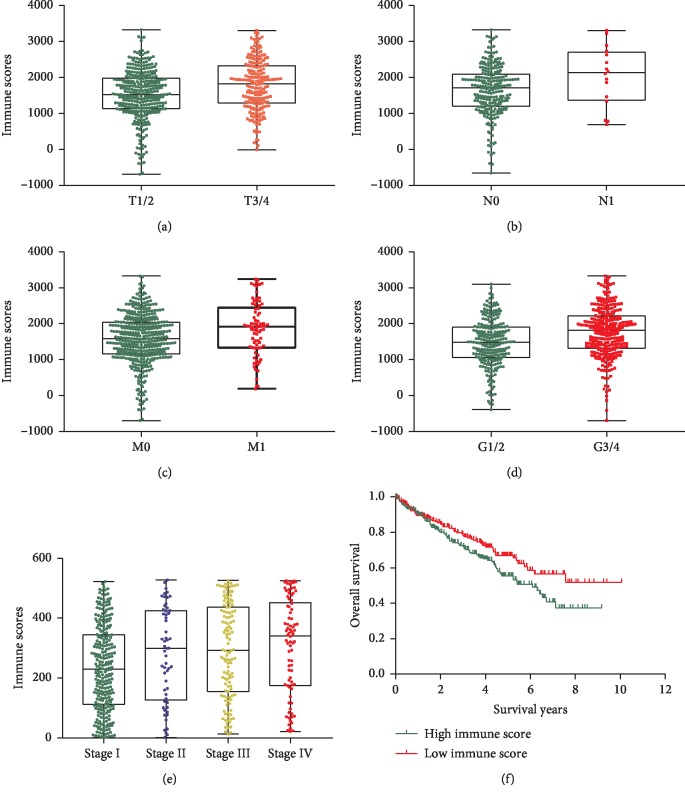
Immune scores were associated with clinical characteristics and overall survival. (a) Distribution of immune scores stratified by T status and box plot indicates a higher immune score was associated with T3/4 (vs. T1/2, P < 0.001). (b) Box plot indicated a higher immune score was associated with N1 (vs. N0, P=0.05). (c) Box plot indicates a higher immune score was associated with M1 (vs. M0, P=0.004). (d) Box plot indicated a higher immune score was associated with G3/4 (vs. G1/2, P < 0.001). (e) Box plot indicated a higher immune score was associated with the advanced AJCC stage (P < 0.001). (f) Kaplan–Meier survival curves for overall survival of ccRCC stratified by immune scores, indicating that the low-score group harbors survival advantage over the high immune score group (P=0.04).